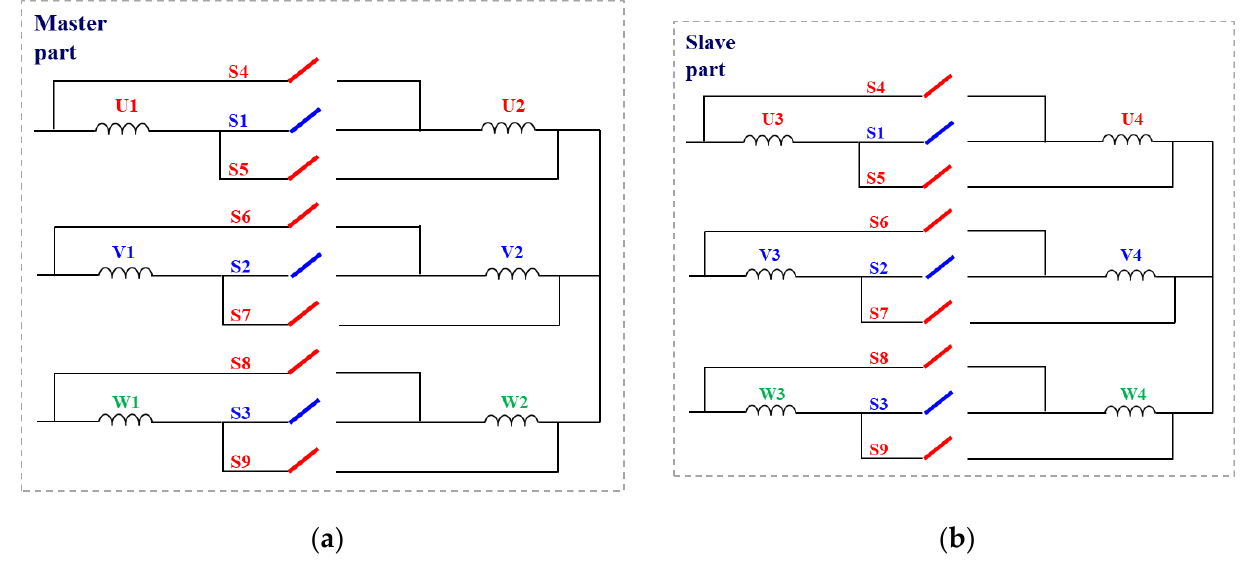
Figure 13. Winding topology of proposed DWM with WS: ( a ) Master part; ( b ) Slave part. In the DWM, the switch connection state is different according to the normal mode and faulty mode, as listed in Table 4. In the normal mode, only switches S1, S2, and S3 are connected to implement a two-parallel winding structure. Table 4. Operation modes of the machine.